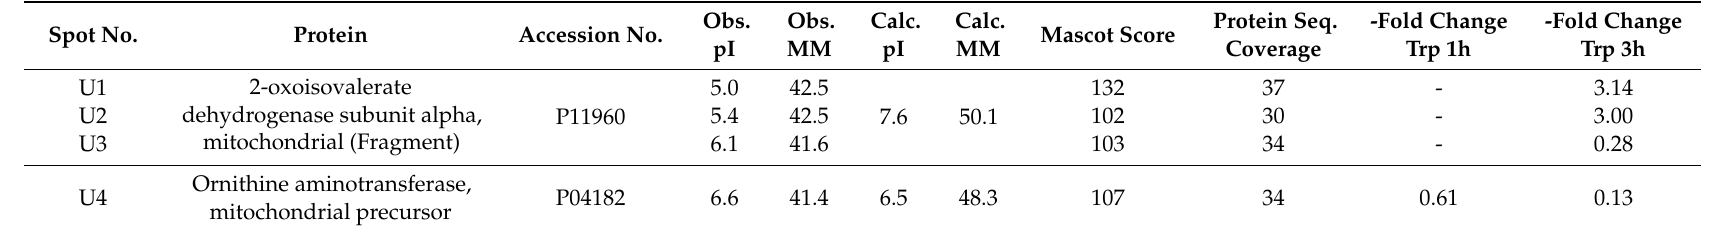
Table 3. Protein identification by peptide mass fingerprinting using MALDI-TOF